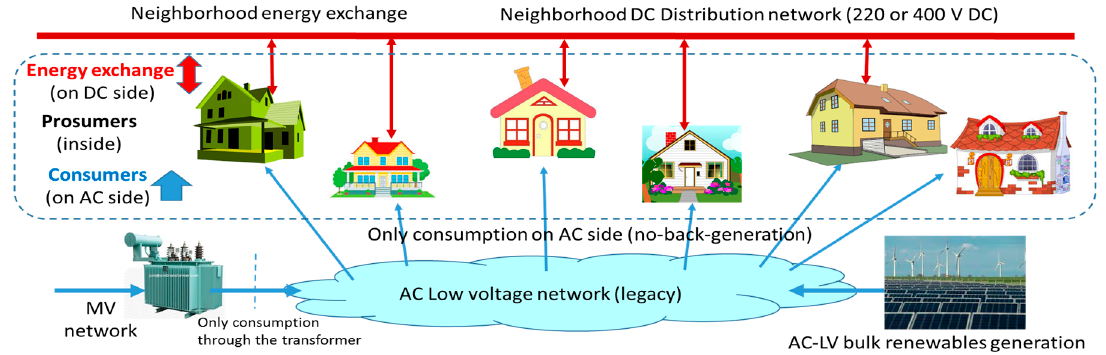
Figure 10. Extension in the neighbourhood (community-level) energy exchange. Energies 2017 , 10 , 1941